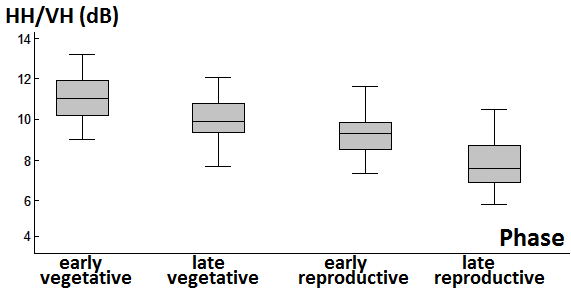
Figure 12. Gradual temporal change of HH/VH data on subdivisions of vegetative and reproductive phase.